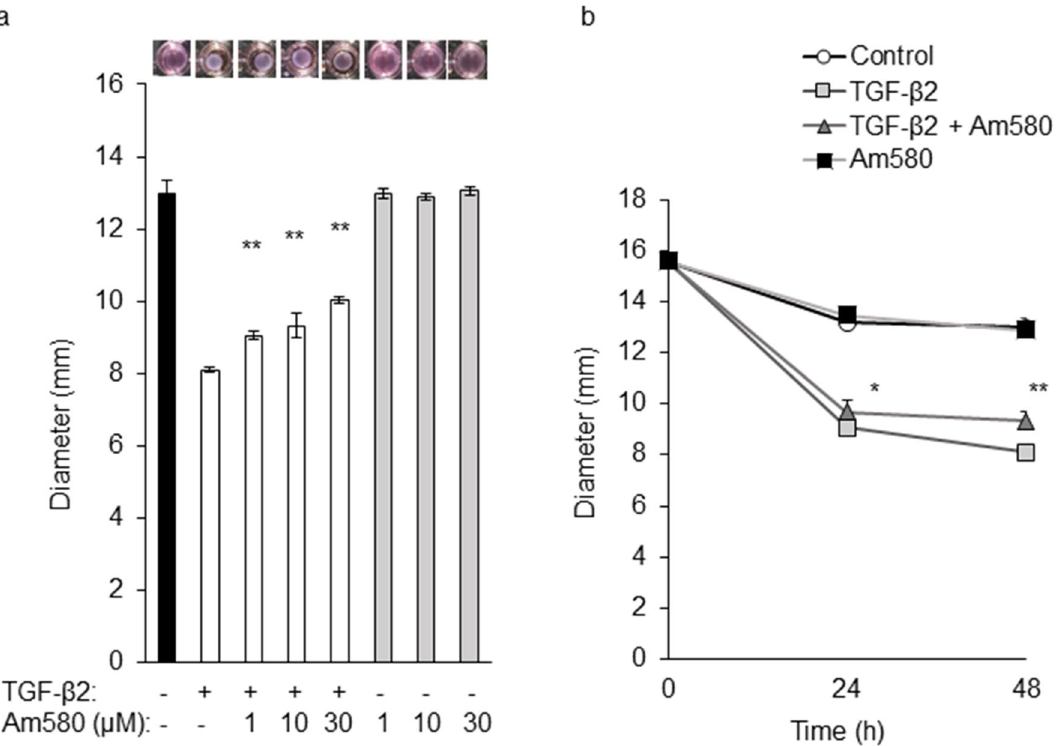
Figure 1. Inhibitory effect of an RAR-α agonist on RPE cell-mediated collagen gel contraction induced by TGF-β2. RPE cells were incubated in collagen gels with or without TGF-β2 (1 ng/ml) and the indicated concentrations (0 to 30 µM) of Am580 for 48 h ( a ) or with or without TGF-β2 (1 ng/ml) and Am580 (10 µM) for 0 to 48 h ( b ), after which the gel diameter was determined. Data are means ± s.d. from four